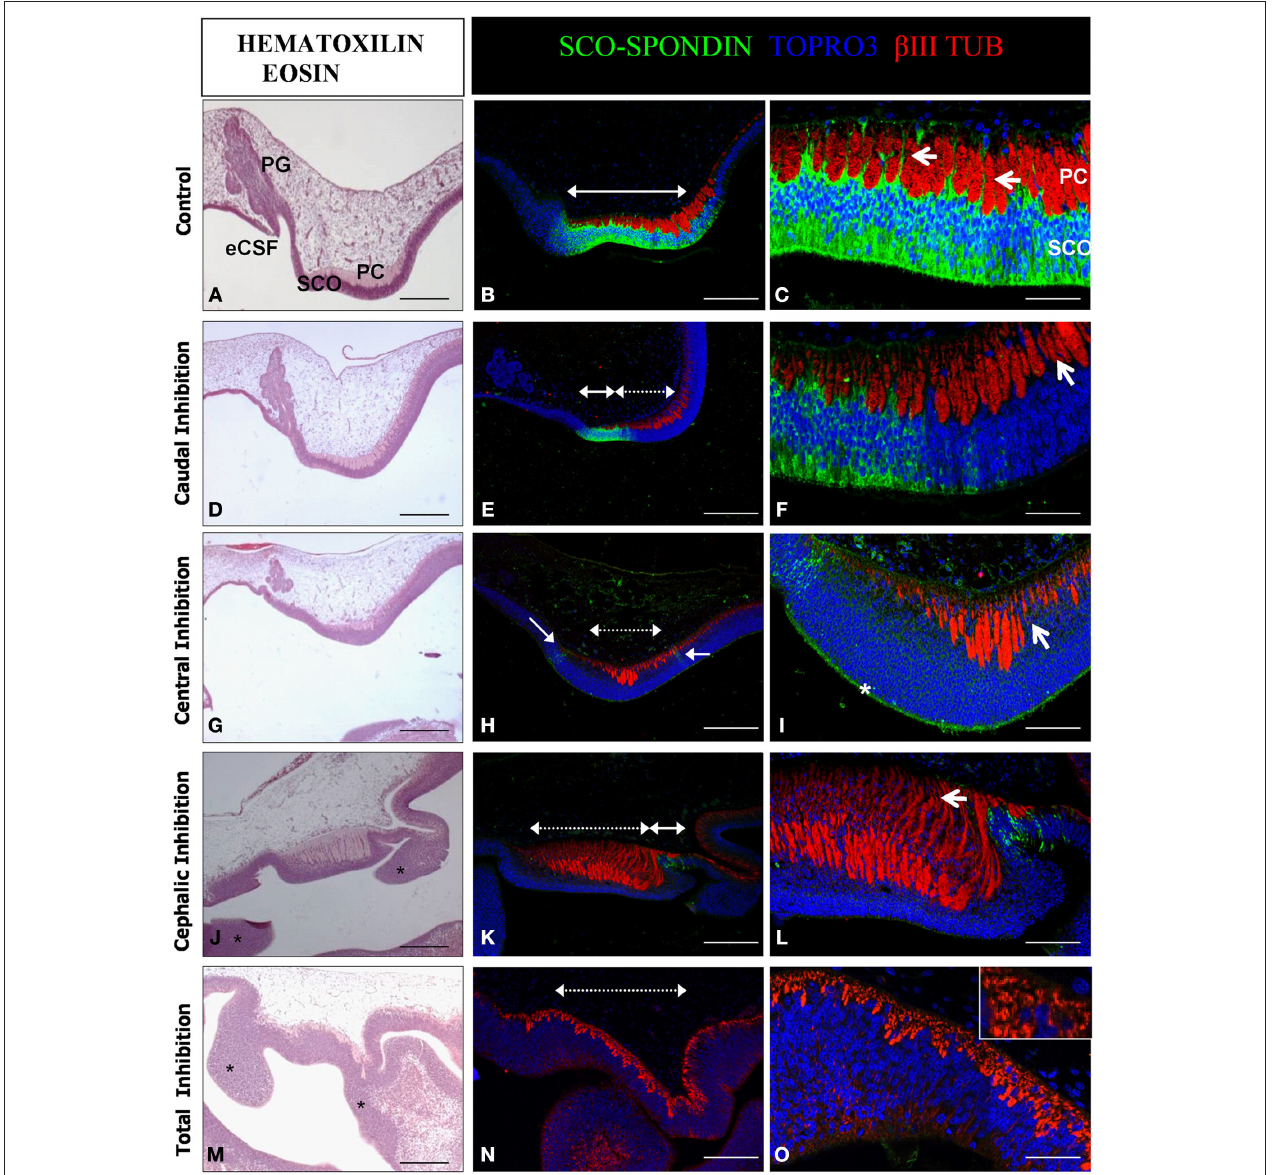
FIGURE 6 | Effect of the SCO-spondin loss of function on diencephalic development. Sagittal sections of dorsal diencephalon of HH29 chick embryos with partial or total inhibition of SCO-spondin, and stained with hematoxilin-eosin (A,D,G,J,M) or with antibodies against SCO-spondin and β III tubulin and counterstained with TOPRO3 (B,C,E,F,H,I,K,L,N,O) . (A–C) Control embryos. (D–O) Embryos with partial or total inhibition of SCO-spondin expression. (D–F), Caudal inhibition; (G–I) , central inhibition; (J–L) , cephalic inhibition; and (M–O) , complete inhibition of SCO-spondin. In (B,E,H,K,N) dotted double arrowheads show the inhibited region, while plain double arrowheads show remnants of SCO-spondin expression. Arrows in (C) show the basal prolongations of the SCO cells. Arrows in (F,I) point at the